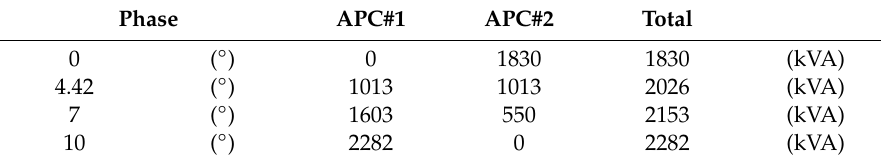
Table 5. Output of APC according to controlled phase.